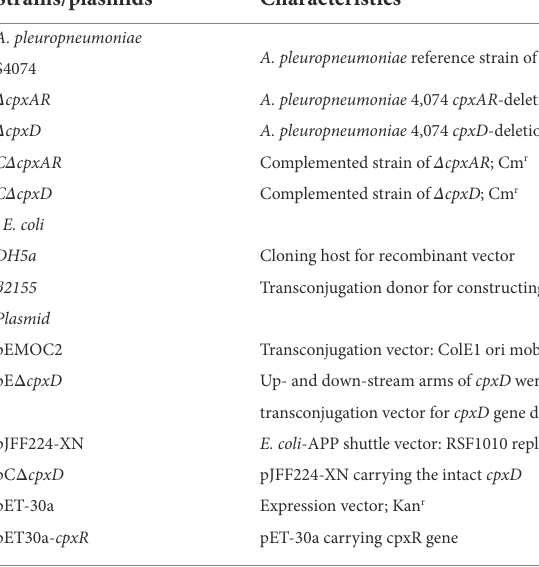
TABLE 1 Bacterial strains and plasmids used in this